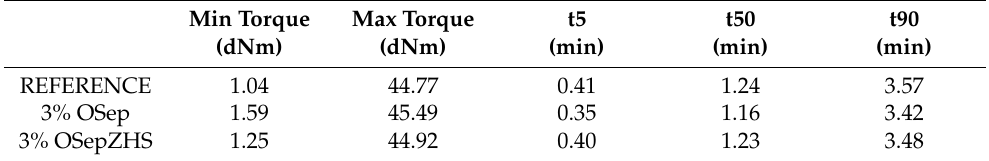
Table 2. Vulcanization parameters for EPDM